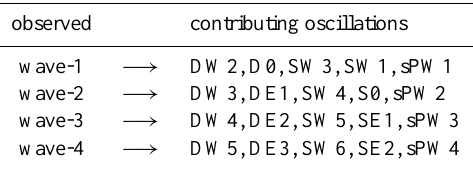
Table 1. The listed diurnal (D) and semidiurnal (S) oscillations propagating either eastward (E) or westward (W) with a given zonal wavenumber, s , or remain standing (0) as well as stationary plane- tary waves (sPW m ) can account for the observed wave- m structures in satellite data taken at a quasi constant